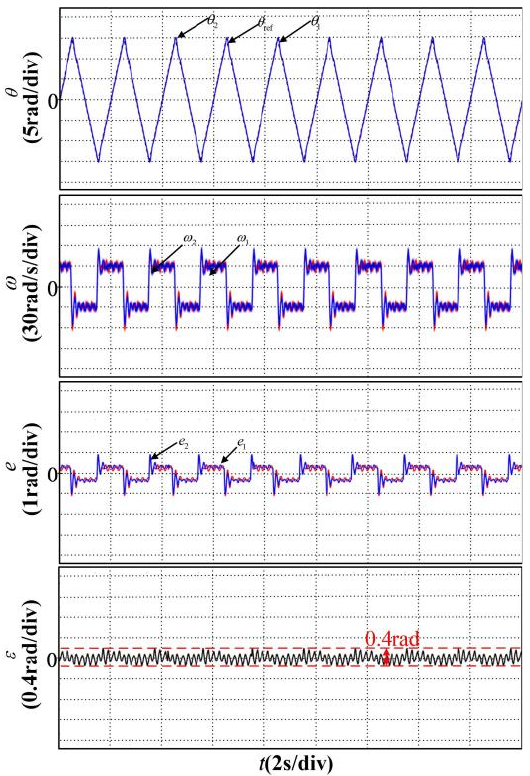
Figure 12. Motor responses when tracking polyline signal.